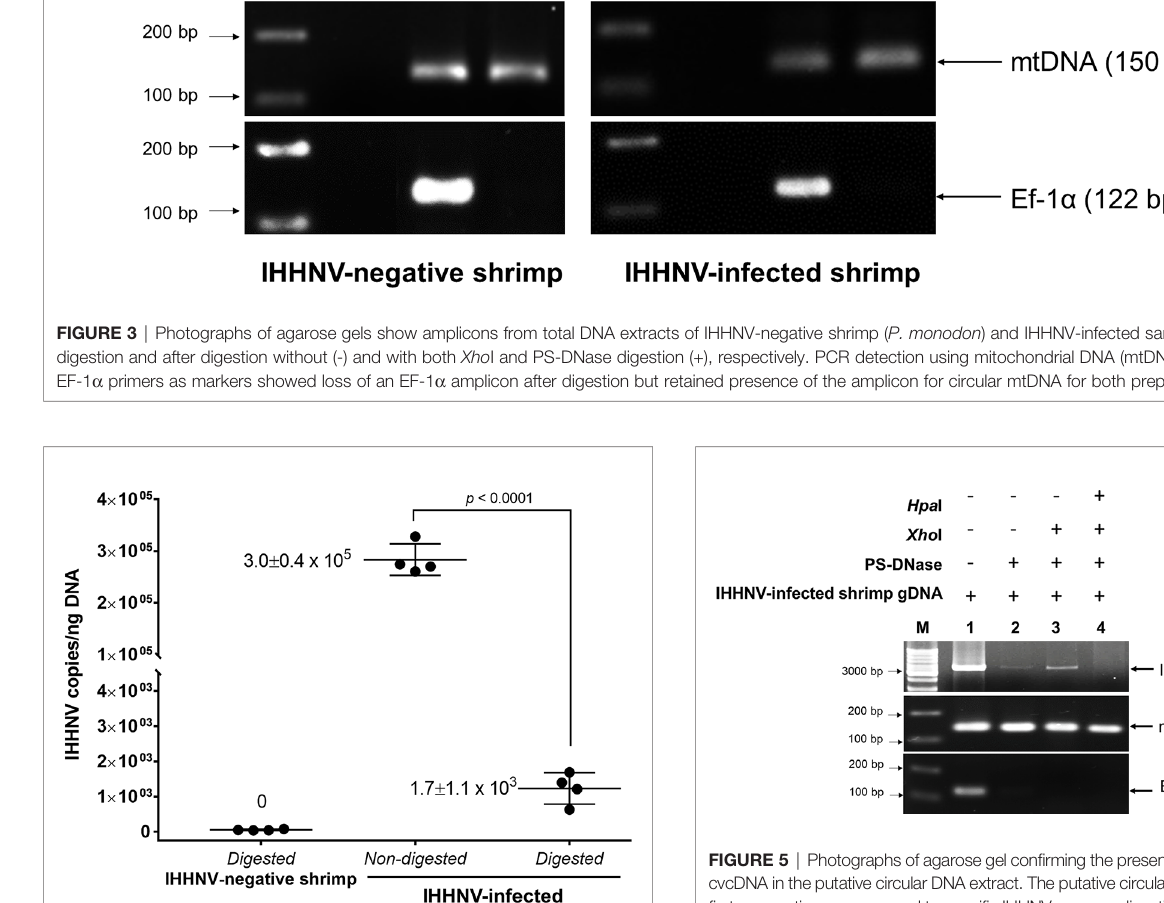
showed that absence of PCR ampliconwas observed post- Hpa I digestion. Whereas, mtDNA representing survivingcircular DNA remained